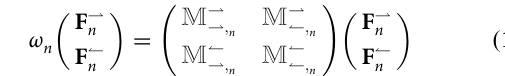
p ffiffiffiffiffiffiffiffiffiffiffi ε = μ ¼ B = Z B , where Z 1 is the wave impedance 1 x = y x = y 1 1